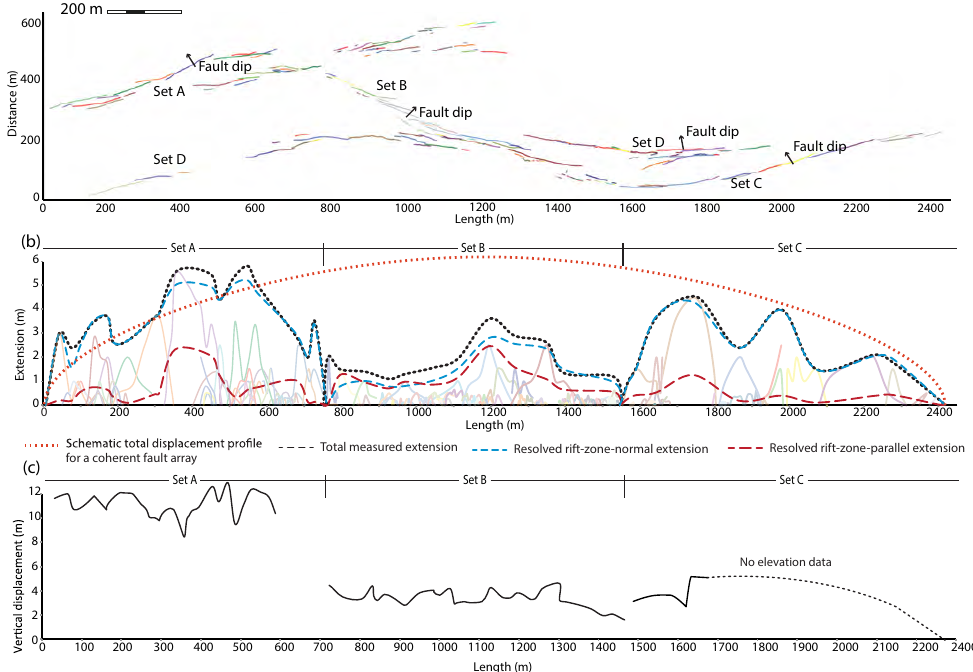
Figure 4. (a) Distribution of mapped fractures in the study area. (b) Profile of horizontal displacement (heave) vs. length for mapped fractures. The dotted grey line indicates cumulative aperture for each set. Dashed blue lines indicate the calculated component of rift-zone- normal extension on each fracture set. Dashed red lines indicate the calculated component of rift-zone-parallel extension on each fracture set. The dotted orange line represents a hypothetical total displacement profile for a single fault (e.g. Gupta and Scholz, 2000), or fully linked, mature fault array (e.g. Childs et al., 2017), in which the maximum displacement is located centrally along the fault or array. (c) Profile of estimated vertical displacement (monocline height and throw) vs. length for segments of surface-breaking faults. No evidence for throw was identified along the NW–SE-striking fractures of set B. With no surface-breaching fault segments along the NW–SE-striking fractures of set B, we present monocline height values only. The dotted line indicates extent of elevation data when the profile is estimated from field observations and aerial